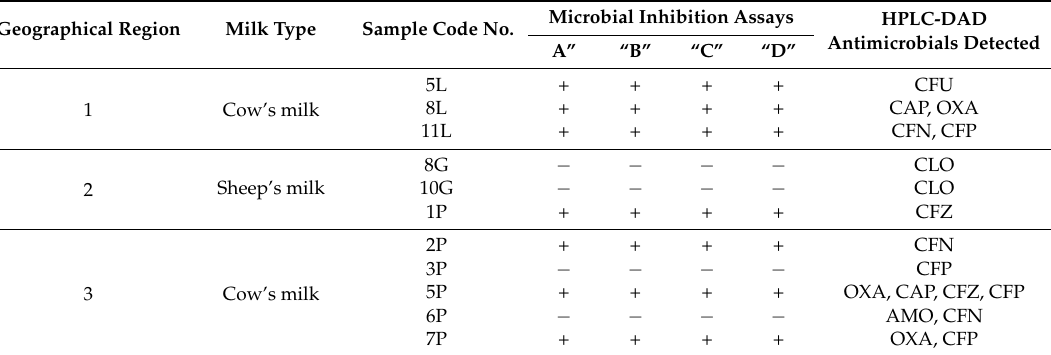
Table 4. Results of the analysis of milk samples with microbial inhibition assays and HPLC-DAD method